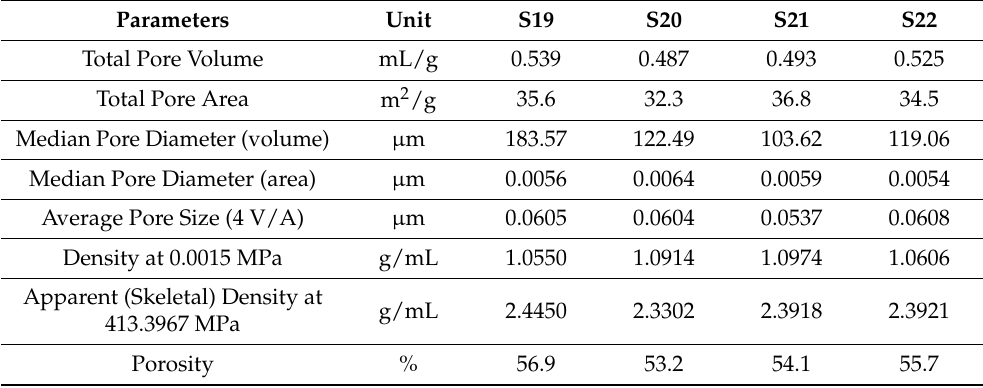
Table 3. Summary of the porosimetry results.